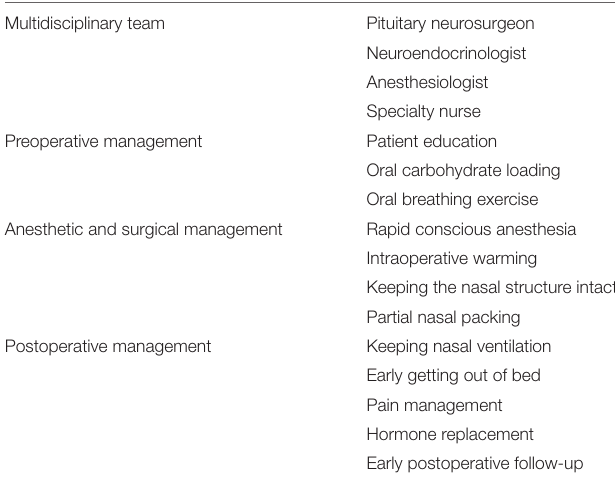
TABLE 1 | Perioperative management protocol of ERAS